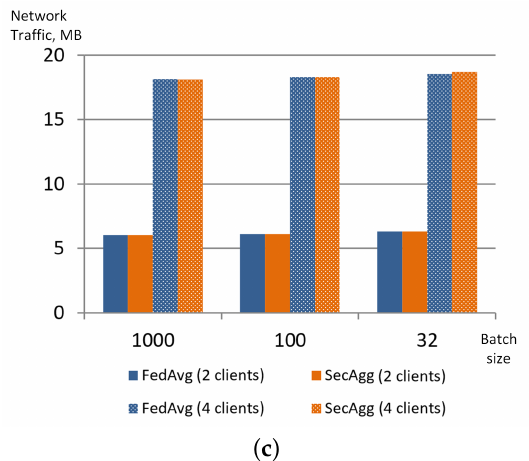
Figure 3. Comparison of different parameters for FedAvg and SecAgg strategies implemented in FATE: accuracy ( a ), training time ( b ), network traffic (MB) ( c